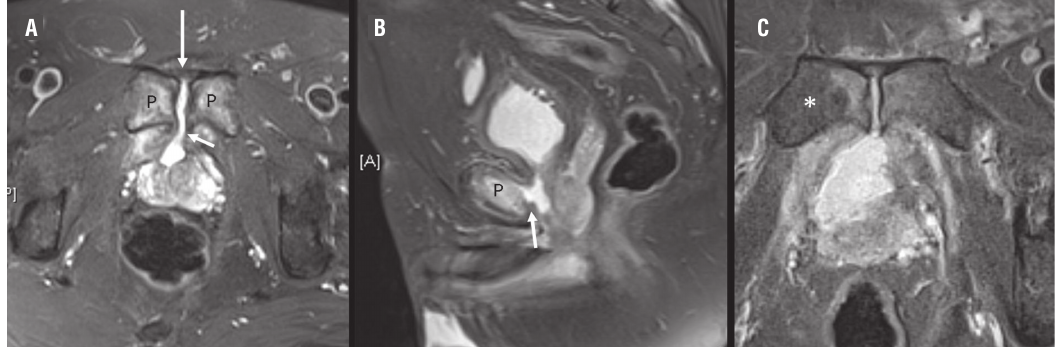
Figure 3 - Pelvic MRI with fat suppression technique. (A) Axial T2 - weighted demonstrates the presence of urine (arrow) through the pubic symphysis (P). (B) Sagittal T2 - weighted shows anterior prostate - symphyseal fistula (arrow). (C) Axial T2 - weighted image displays edematous changes within both pubic bones, most markedly on right side